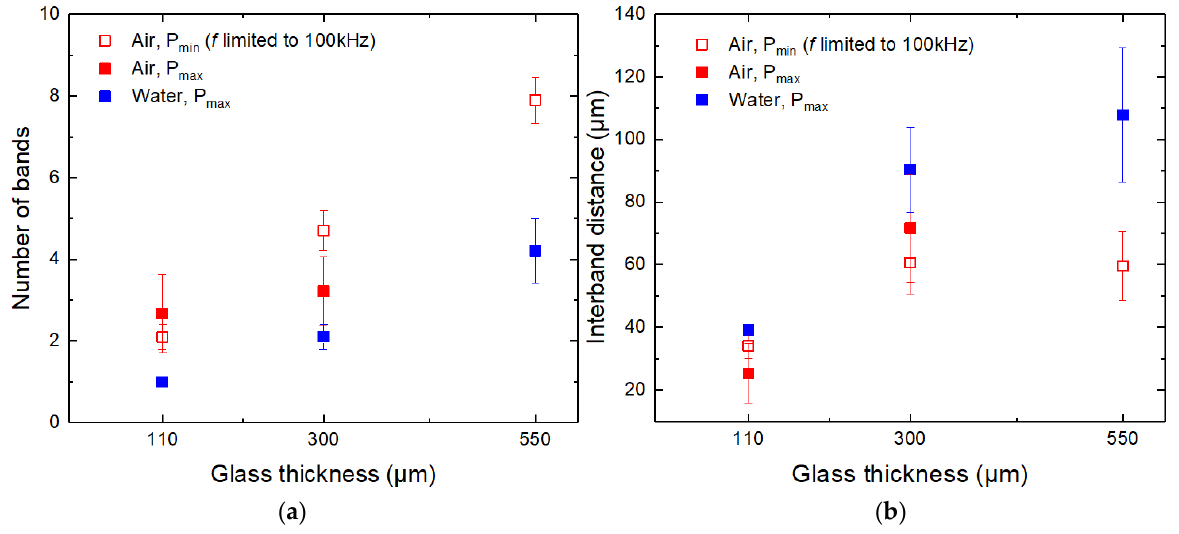
Figure 11. Number of damage bands ( a ) and distance between the bands ( b ) versus glass thickness in water and ambient air cutting environments. Error bars indicate the standard deviation.